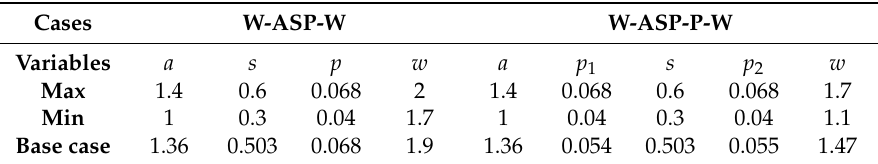
Table 5. Constraints of the design variables (wt